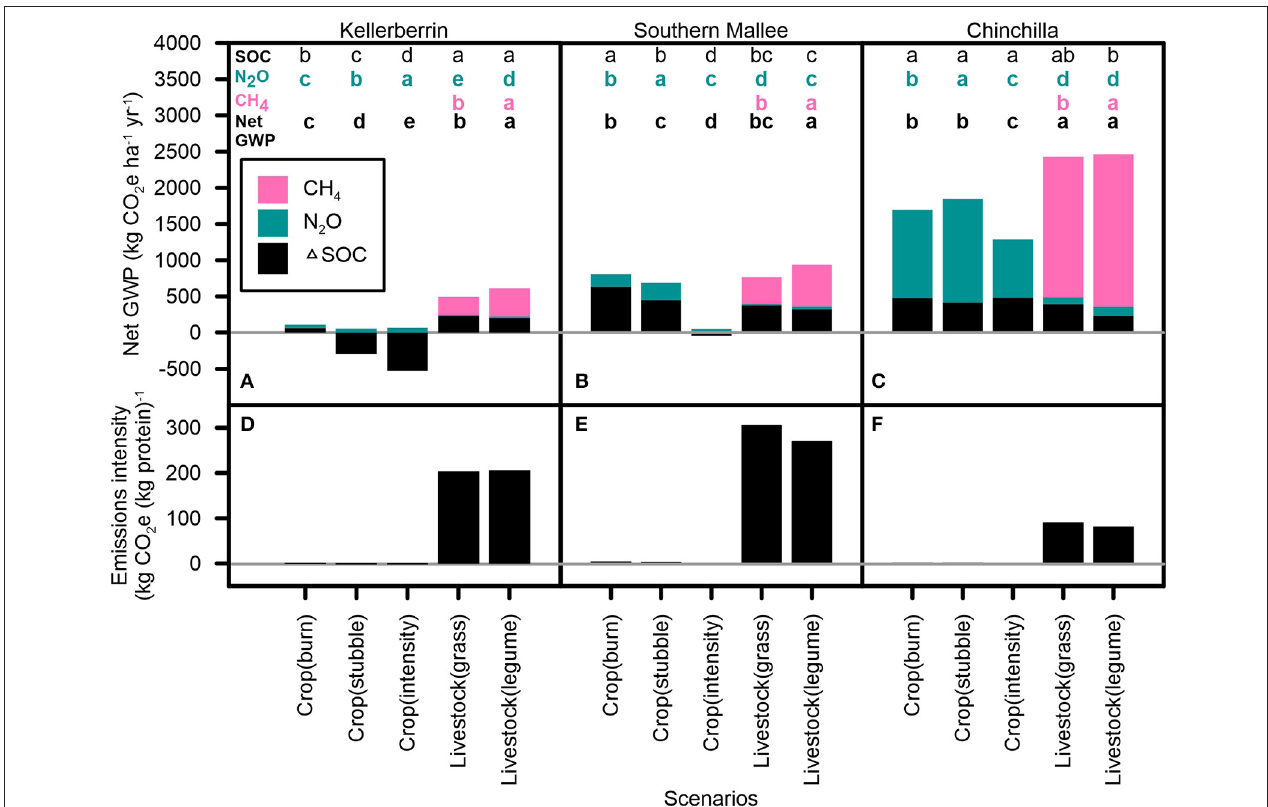
FIGURE 7 | Average net global warming potential (GWP) (A–C) and emissions intensities (D–F) for the cropping scenarios, Crop burn (burnt stubble), Crop stubble (retained stubble), and Crop intensity (increased cropping intensity), and livestock scenarios, Livestock grass (permanent grass pasture) and Livestock legume (permanent improved pasture), at the Kellerberrin, Southern Mallee, and Chinchilla case study farms. In (A–C) , net GWP is the sum of average annual on-farm emissions of (1) CO 2 associated with the change in soil organic carbon ( 1 SOC), (2) N 2 O from the soil, manure and urine, and (3) CH 4 from enteric fermentation and from manure. Scenarios that differ by more than the honestly significant difference value in these individual emissions or net GWP have a different letter shown at the top of the panel. Negative values for net GWP represent abatement from the scenarios. Emissions represent the average of values from the 100 yr simulation period. In (D–F) , emissions intensities are calculated for cropping in terms of harvested grain protein and for livestock scenarios in terms of the protein content of dressed animal carcasses sold. Long-term average emissions intensities for cropping systems were very small [ − 1.2 to 4.3kg CO 2 e (kg protein) − 1 ] and may be difficult to distinguish for some farm-scenario